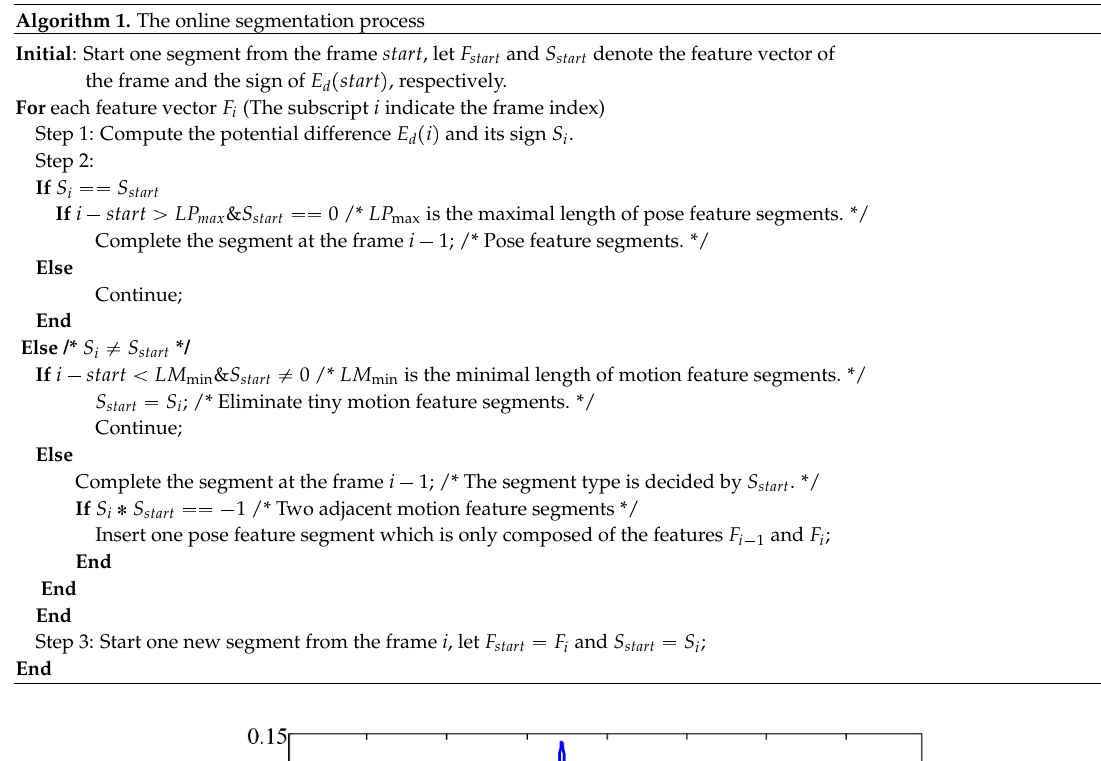
Algorithm 1. The online segmentation process